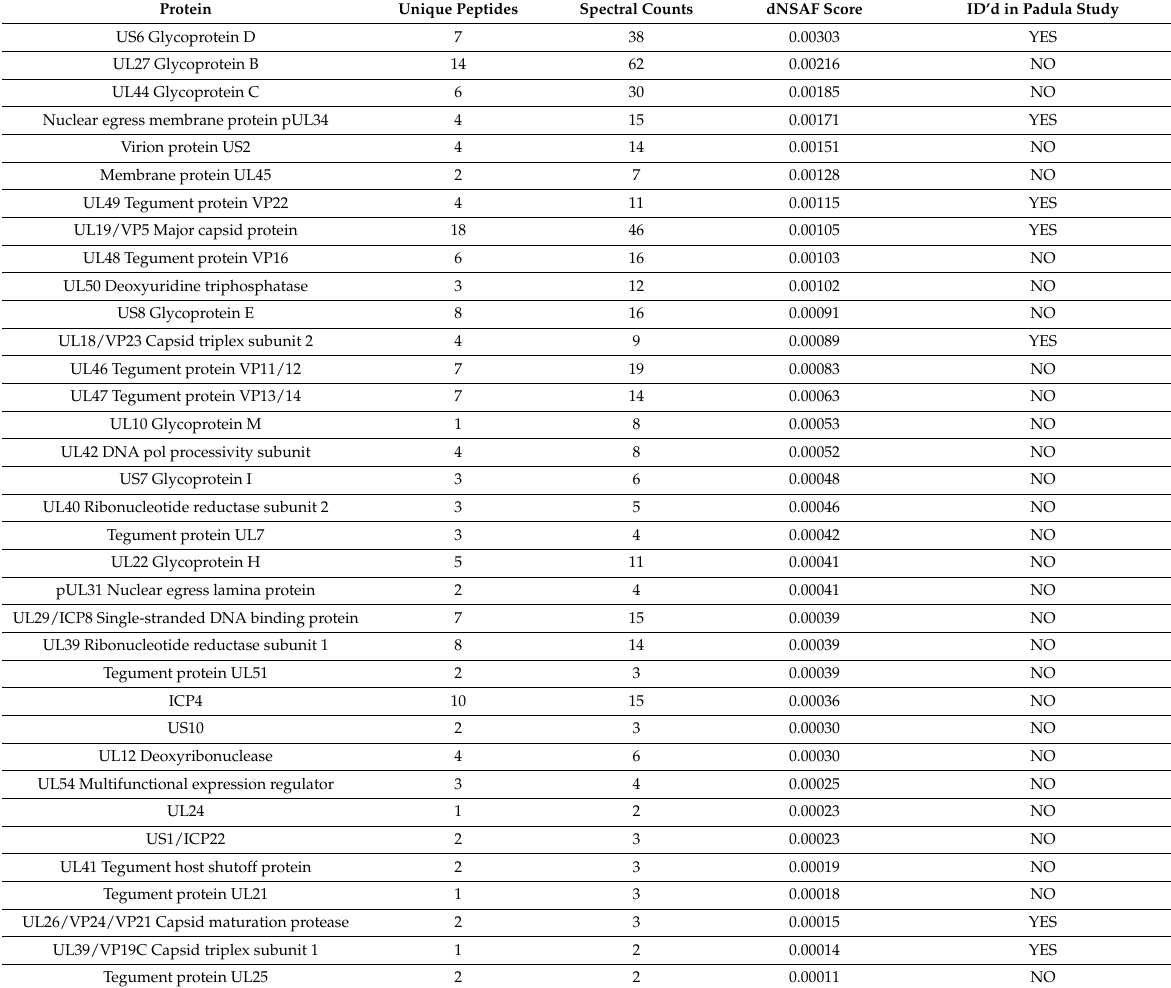
Table 1. Abundance of viral proteins identified in HSV-1 infected